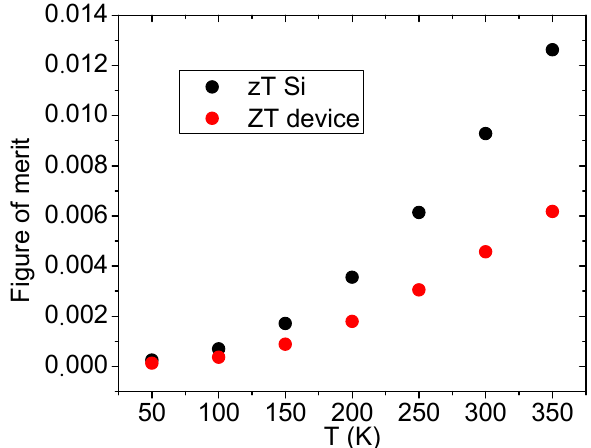
Figure 4. Comparison of the zT of the Si and the ZT of the device.